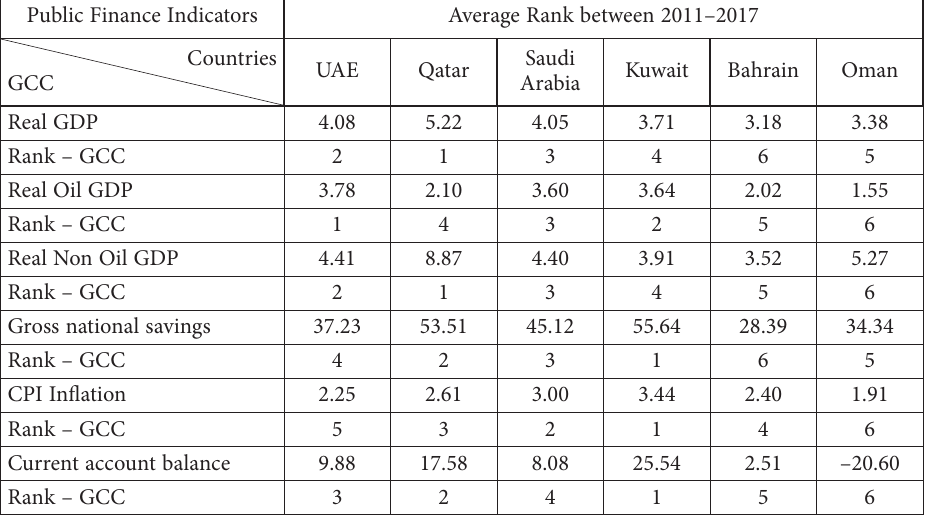
Table 4. National accounts indicators of GCC countries and rank (source: International Monetary Fund, World Economic Outlook Database (2018) From 2011–2017. Source of Rank: author) Average Rank between 2011–2017Public Finance Indicators